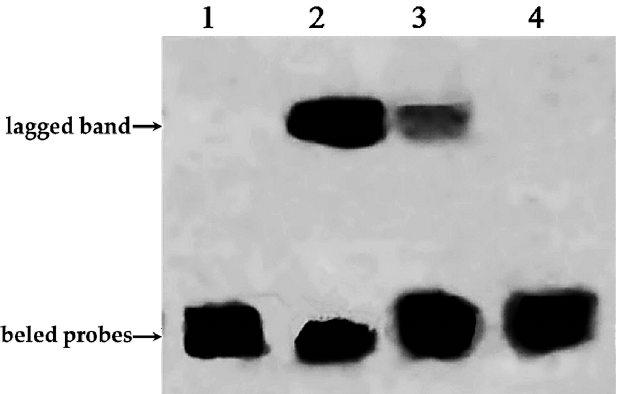
Figure 6. Electrophoretic mobility shift assay results of PnbHLH1 protein binding to E-box cis-acting elements. 1. Adding free probes labeled with biotin; 2. Adding free probes labeled with biotin and target protein; 3. Adding free probes labeled with biotin, target proteins, and competitive probes not labeled with biotin; and 4. Adding mutant probes labeled with biotin and target protein.